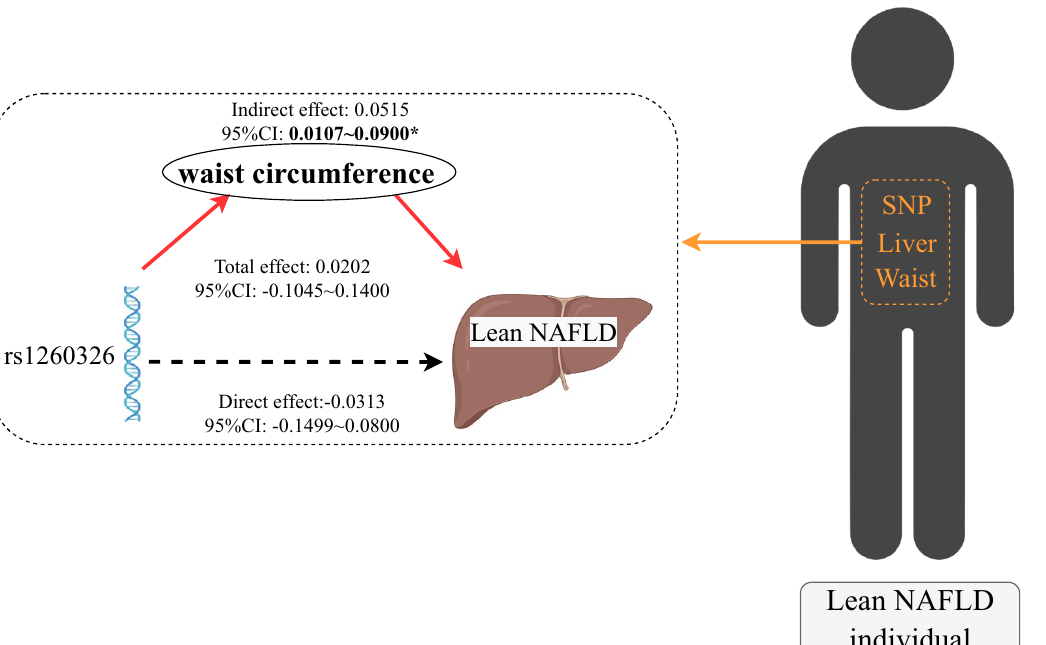
Figure 2. Mediation of waist circumference on the association between rs1260326 and lean NAFLD. NAFLD non-alcoholic fatty liver disease. In this study, rs1260326-C had no significant direct effect on lean NAFLD (95% CI − 0.1499 to 0.0800), rs1260326-C had a significant indirect effect on lean NAFLD incidence via waist circumference (95% CI 0.0107–0.0900). Zero was not included in 95% confidence intervals representing statistical significance (p =